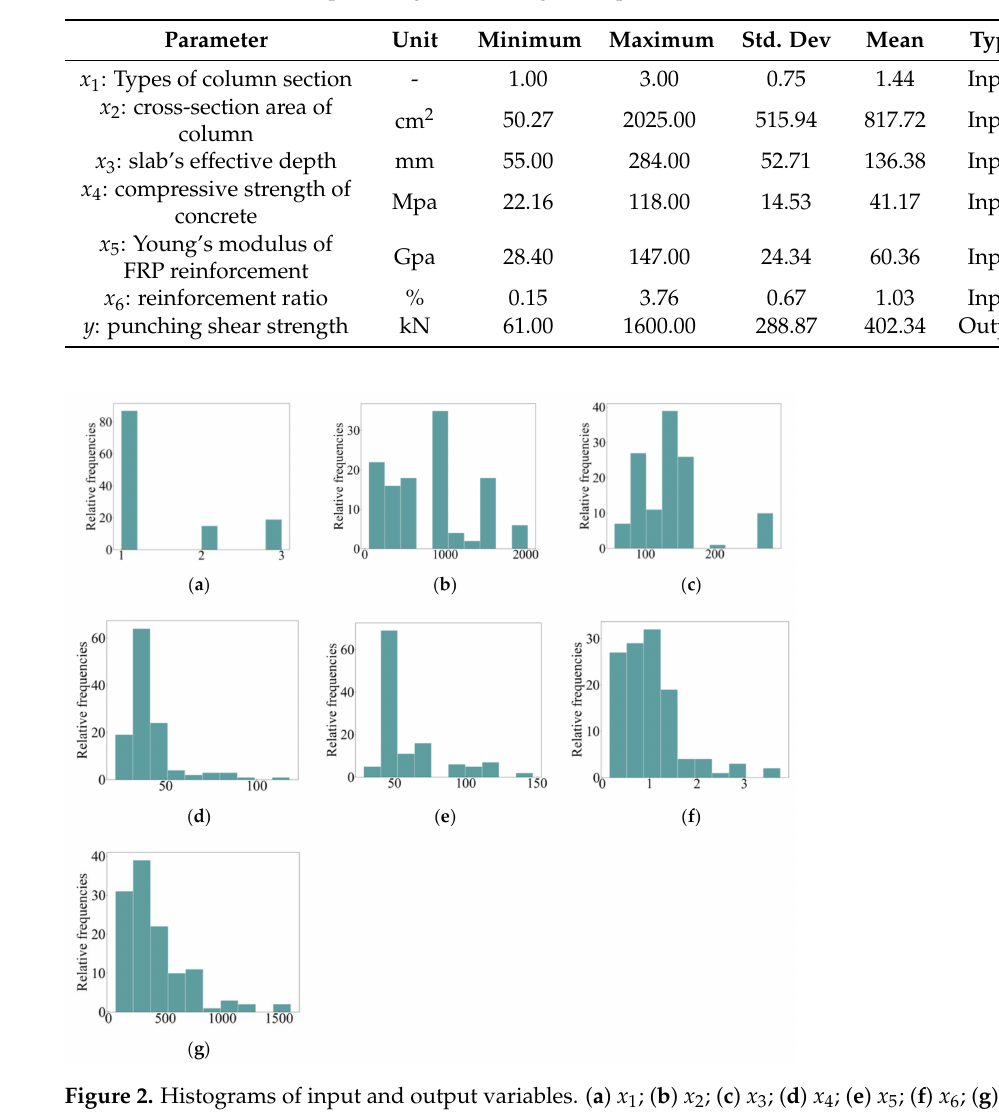
Table 1. Parameters in the punching shear strength samples.